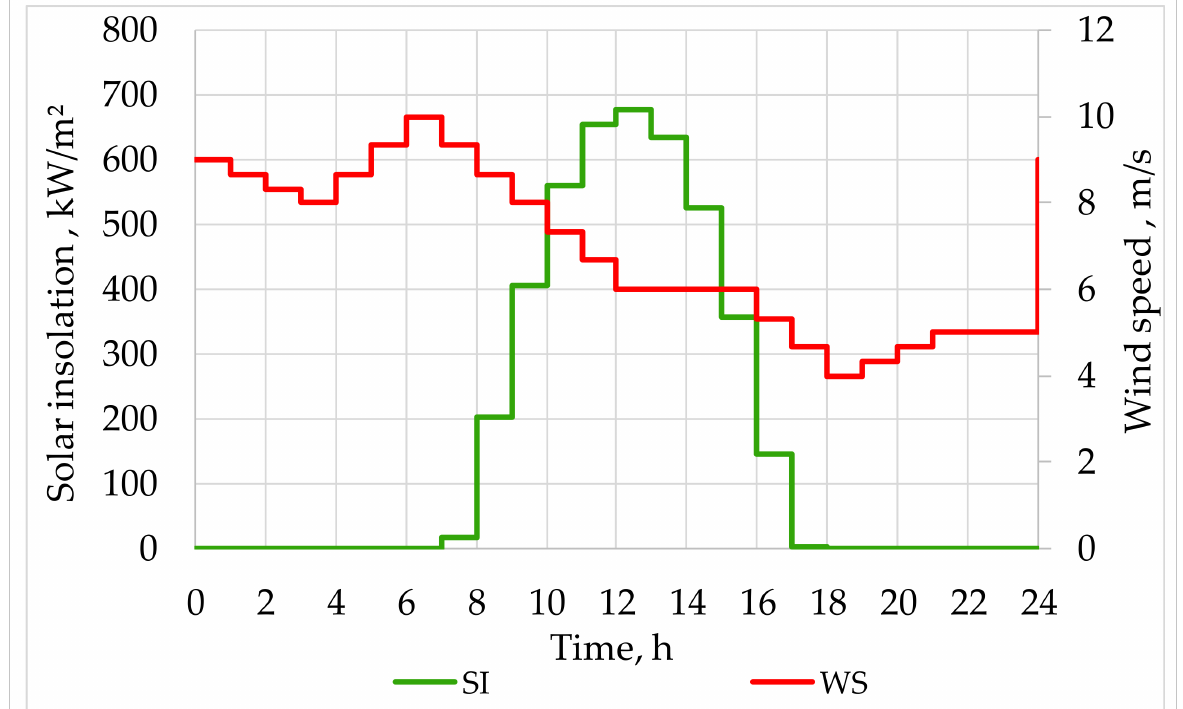
Figure 3. Wind speed and solar insolation data of a typical winter